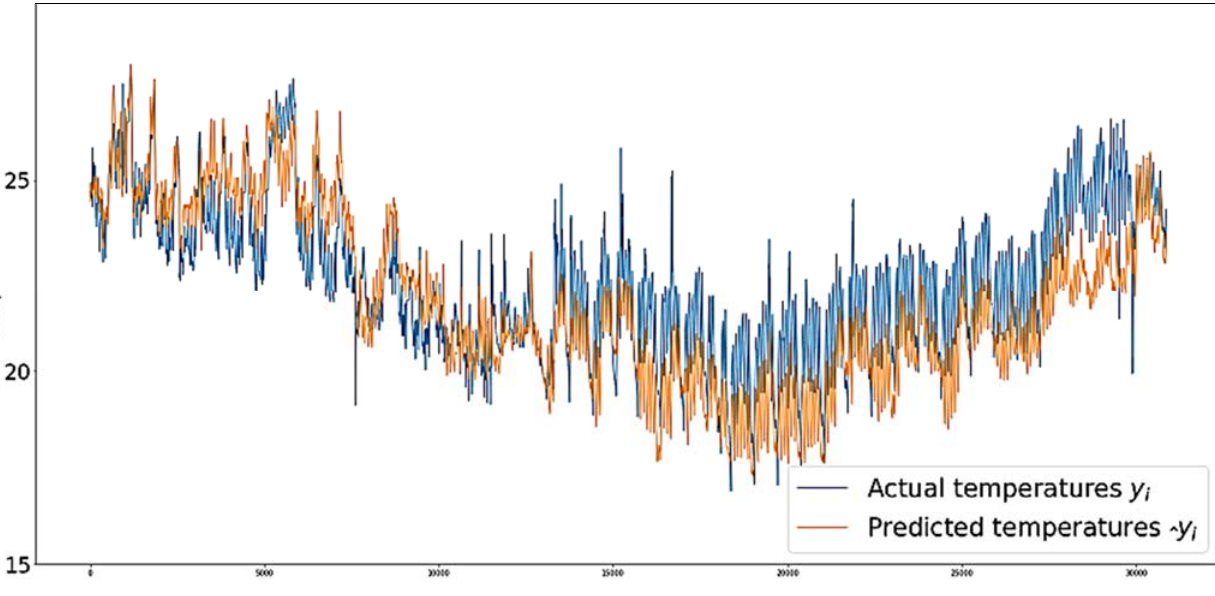
Figure 23. Plot of actual and predicted temperatures 24 h ahead for office 40 on the third floor.